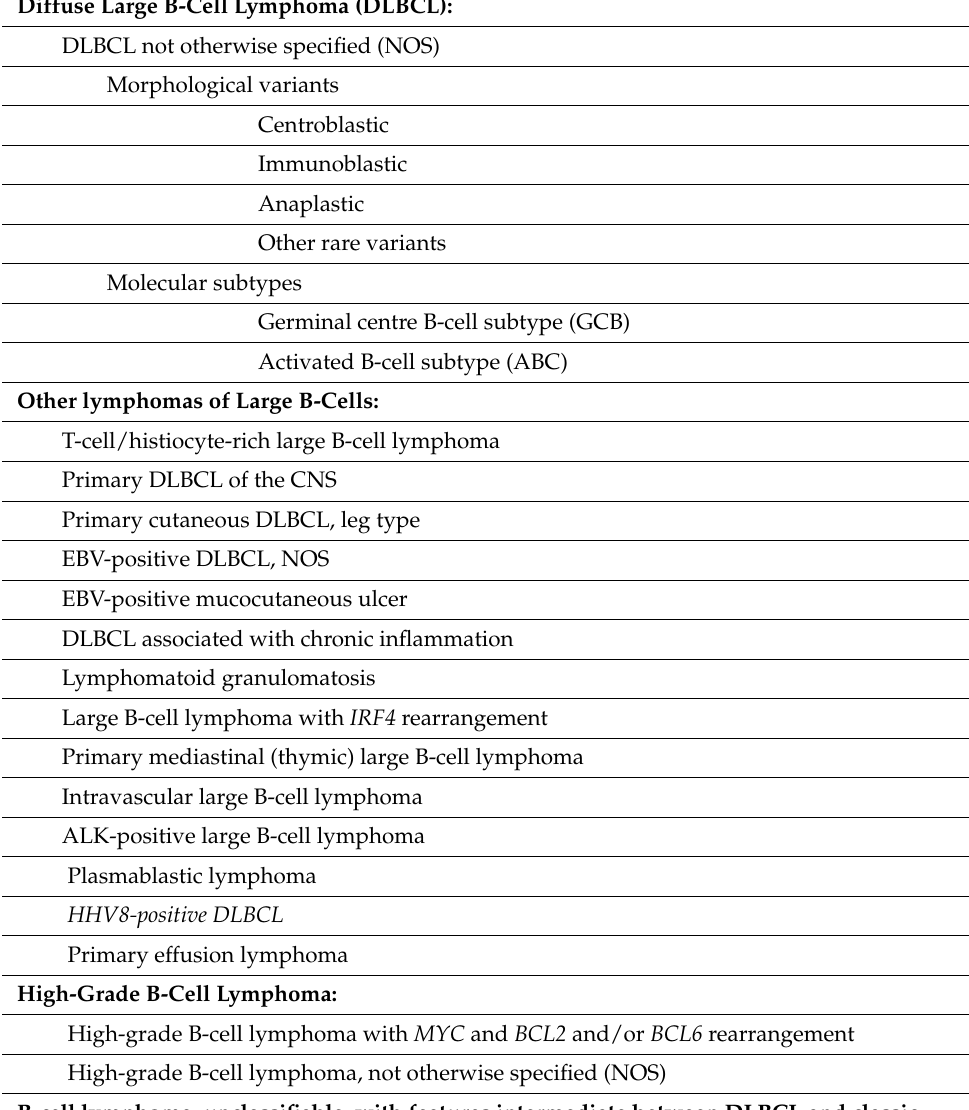
Table 1. Diffuse large B-cell lymphoma, high-grade B-cell lymphoma, and gray-zone lymphoma according to the Revised Fourth Edition of the WHO Classification of Tumours of Haematopoietic and Lymphoid Tissues (italics indicate that an entity is